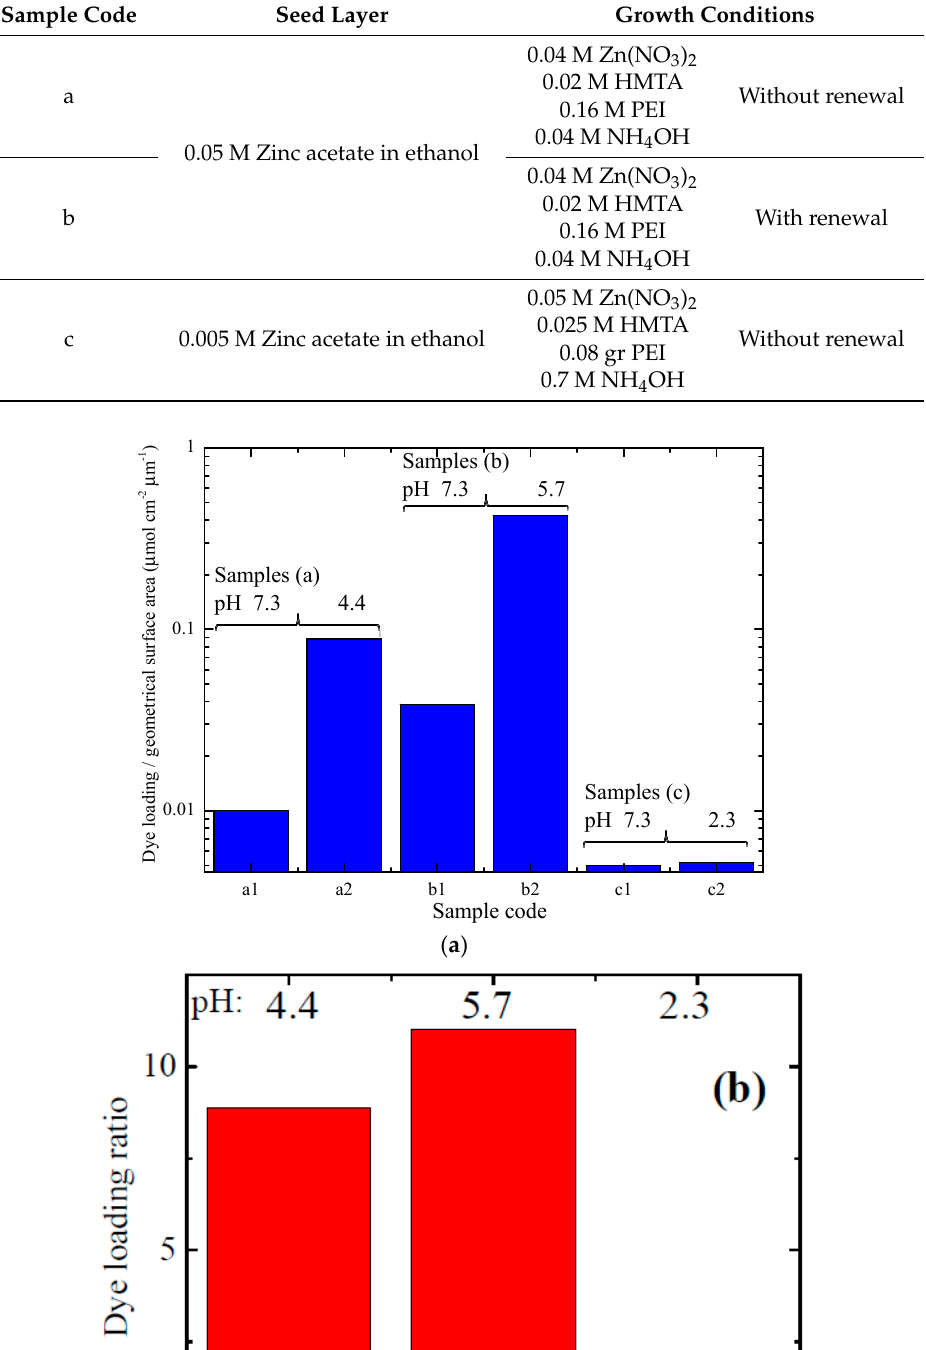
Table 2. Growth conditions of the three types of samples shown in Figure 8.